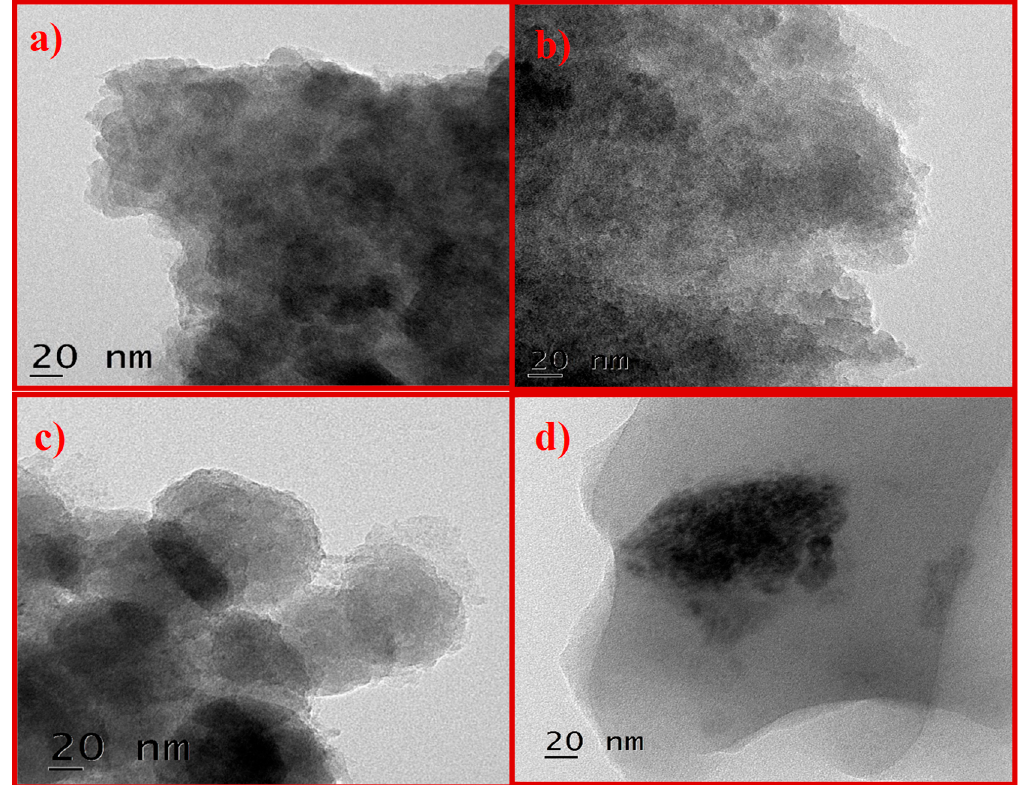
Figure 4. Representative HRTEM images of K–GO ( a ), N–GO ( b ), F–GO ( c ), and C–GO ( d ).